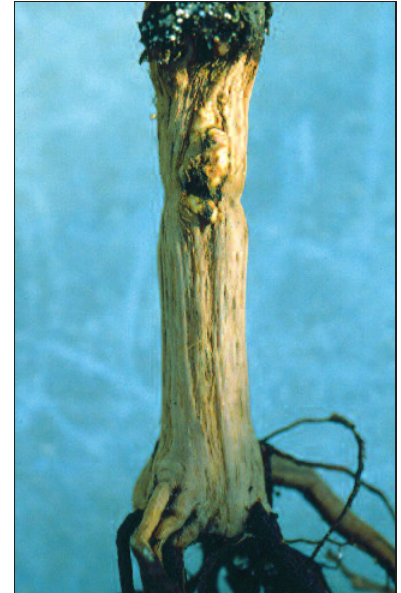
Figure 9 . Rupestris stem pitting (GRSPaV) symptoms on Vitis rupestris St. George: pits below the donor tissue inoculated by chip- buddung